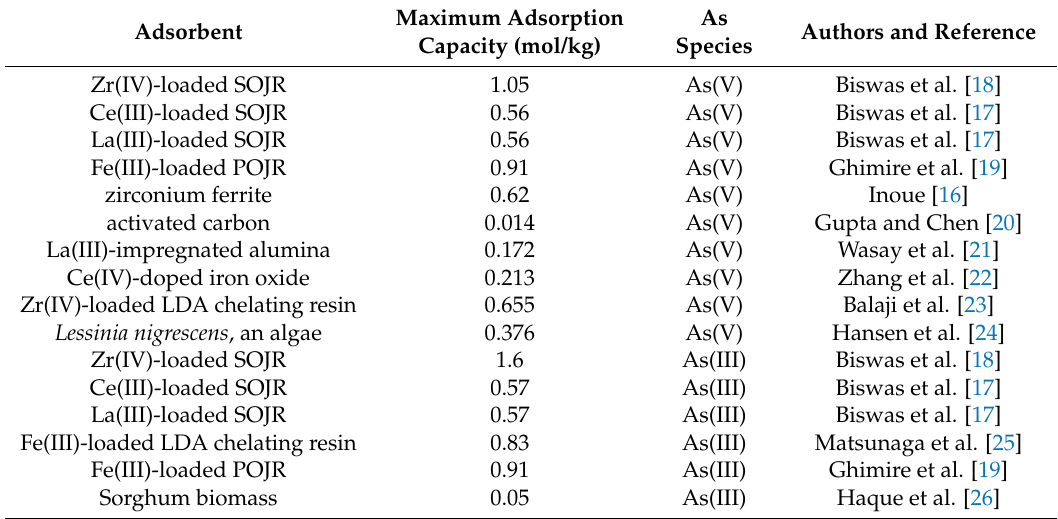
Table 1. Maximum As(V and III) adsorption capacities of the biosorbents and other adsorbents.